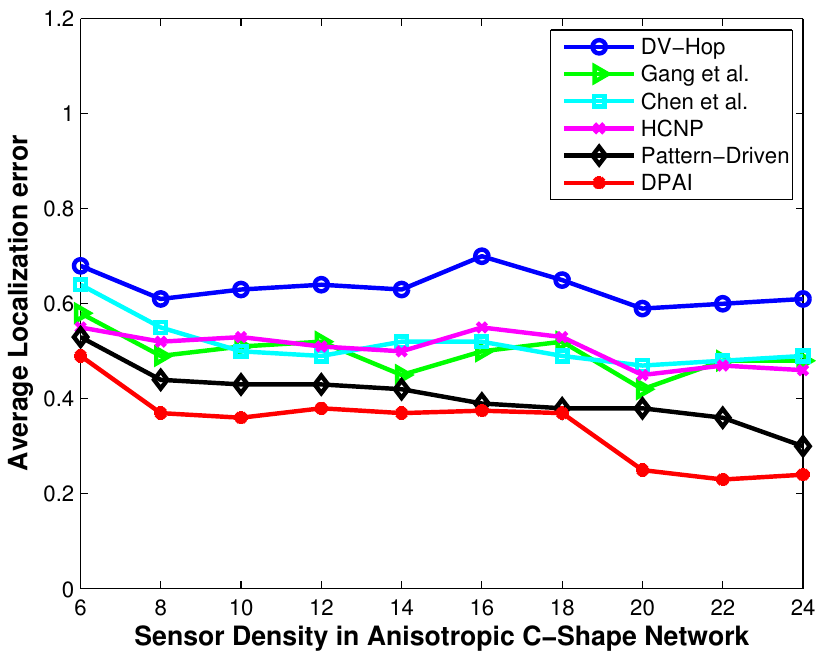
Figure 9. Localization error vs . sensor density (C-shape